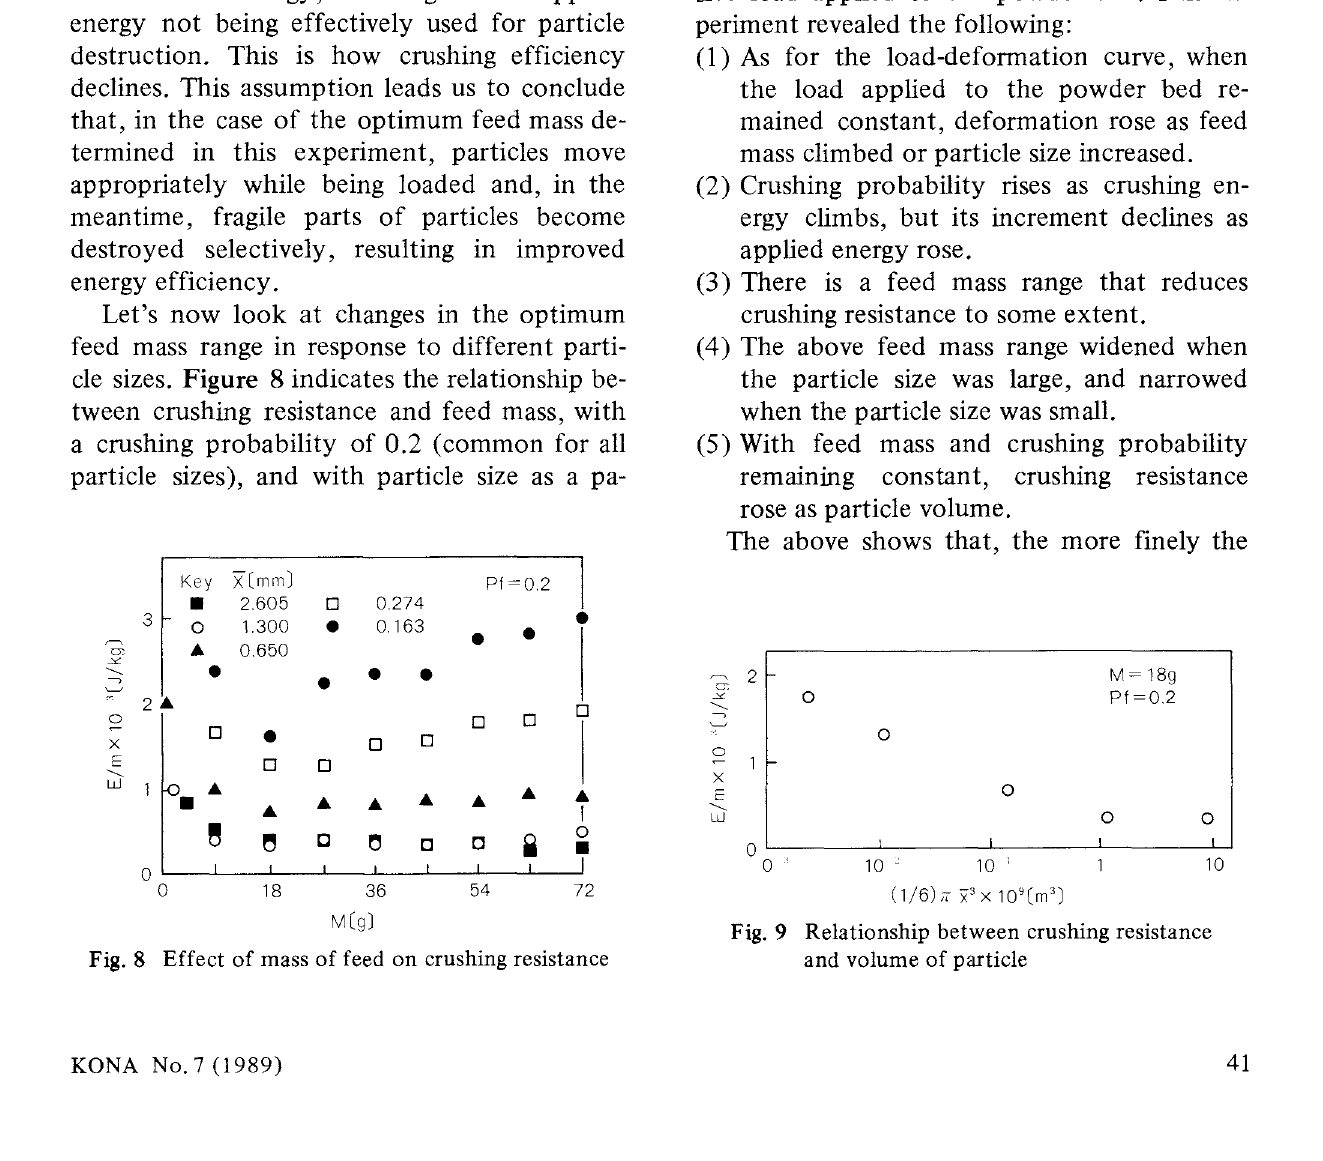
Fig. 9 Relationship between crushing resistance and volume of